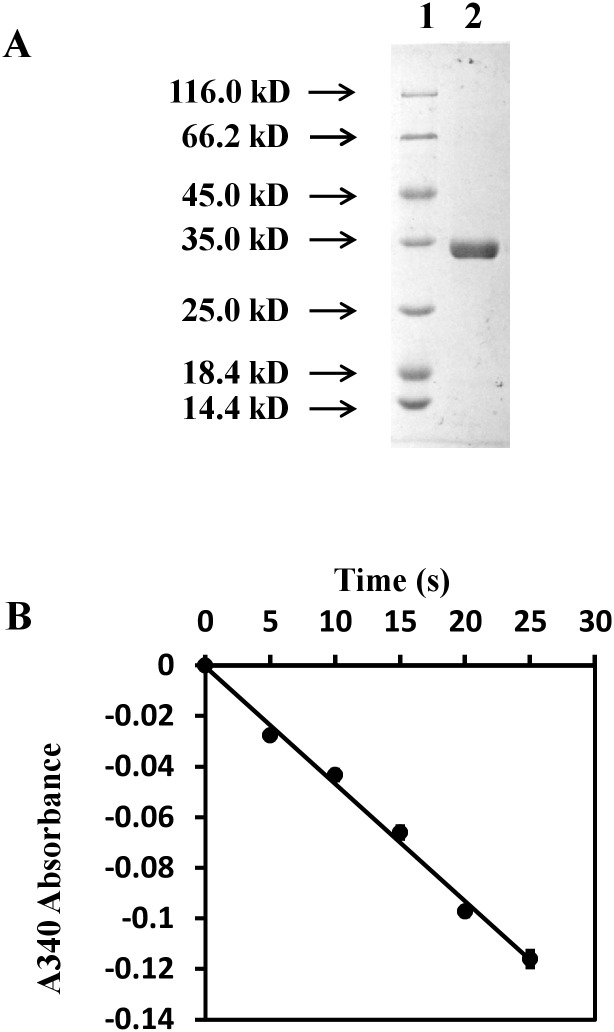
Purification and functional identification of MtbCitE protein.Identification of citrate cleavage activity embraced by MtbCitE. The measurement of citrate cleavage activity was coupled with MDH assay. Oxaloacetate, product of CitE, is used as the substrate of MDH combined with oxidation of NADH, which was monitored spectrophotometrically at 340 nm. The values presented are the average values of three independent experiments, and 0.49 mg of CitE was added in the reaction mix. The line in the graph shows the trend of NADH oxidation rate, which represents the enzyme activity of MtbCitE.